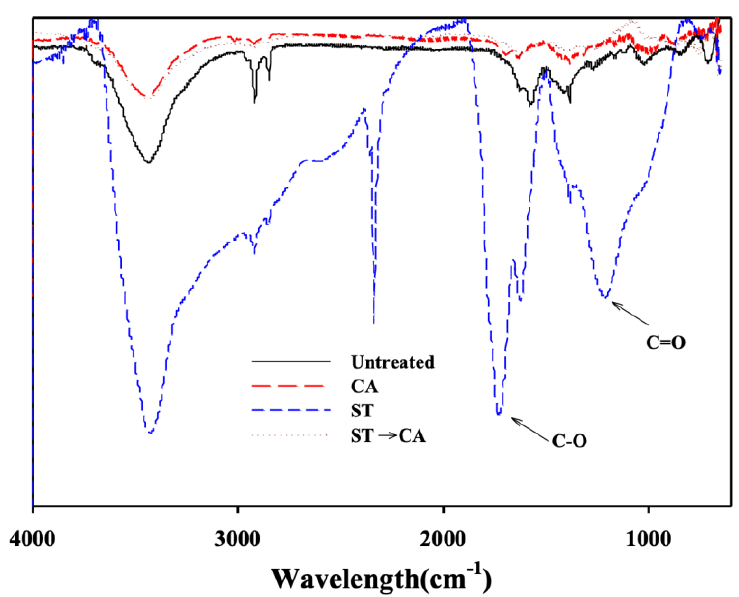
Figure 6. FT-IR (Fourier Transform Infrared Spectroscopy) results of ACFs ST-CA process (Untreated, untreated ACFs; ST, ACFs prepared through surface treatment; CA, ACFs prepared through chemical activation without prior surface treatment; ST → CA, ACFs prepared through chemical activation after surface treatment).